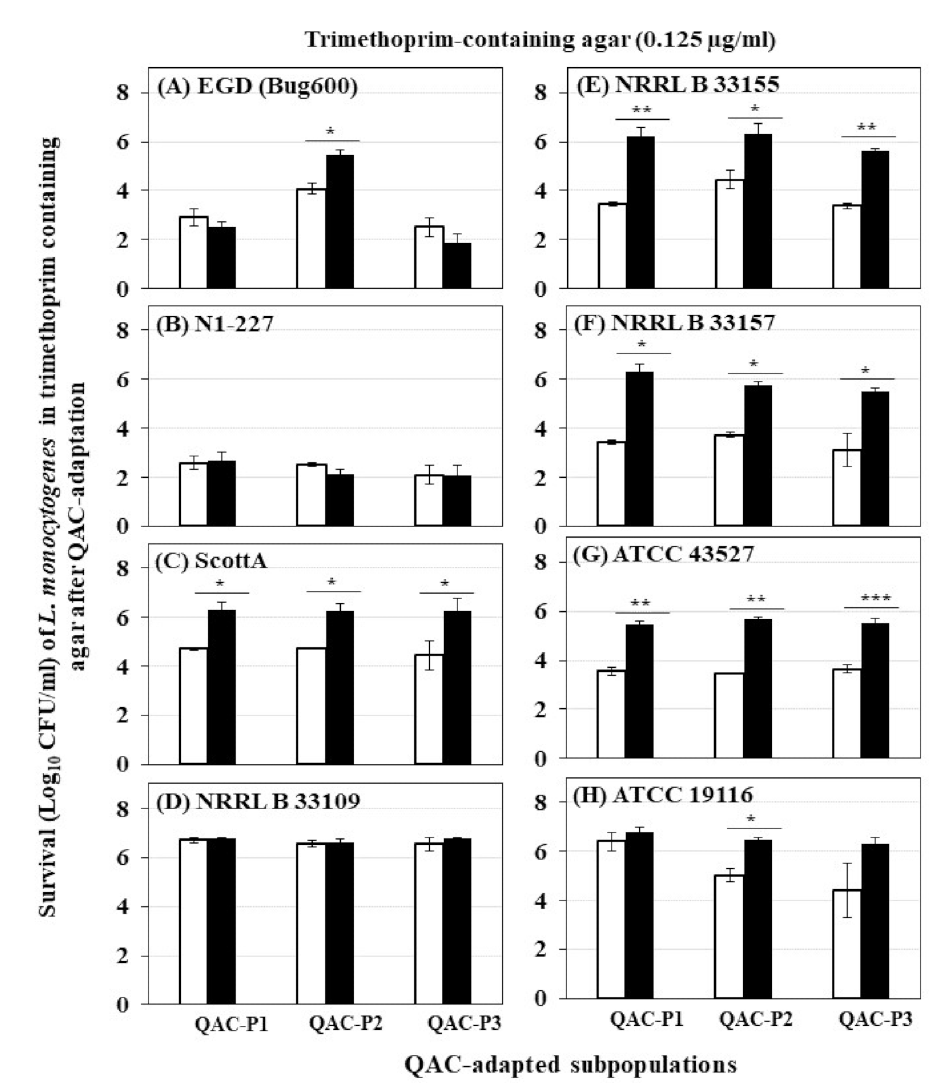
Figure 4. Survival (Log 10 CFU/mL) of three QAC-adapted subpopulations (closed bars) and non- adapted control (open bars) of eight L. monocytogenes strains in trimethoprim-containing agar: ( G ) ATCC 43527, ( H ) ATCC 19116. Error bars indicate standard errors of means. Statistically signif- icant P values are indicated by asterisks (*, p < 0.05; **, p < 0.01; ***, p < 0.001) that were obtained using the unpaired two-tailed t